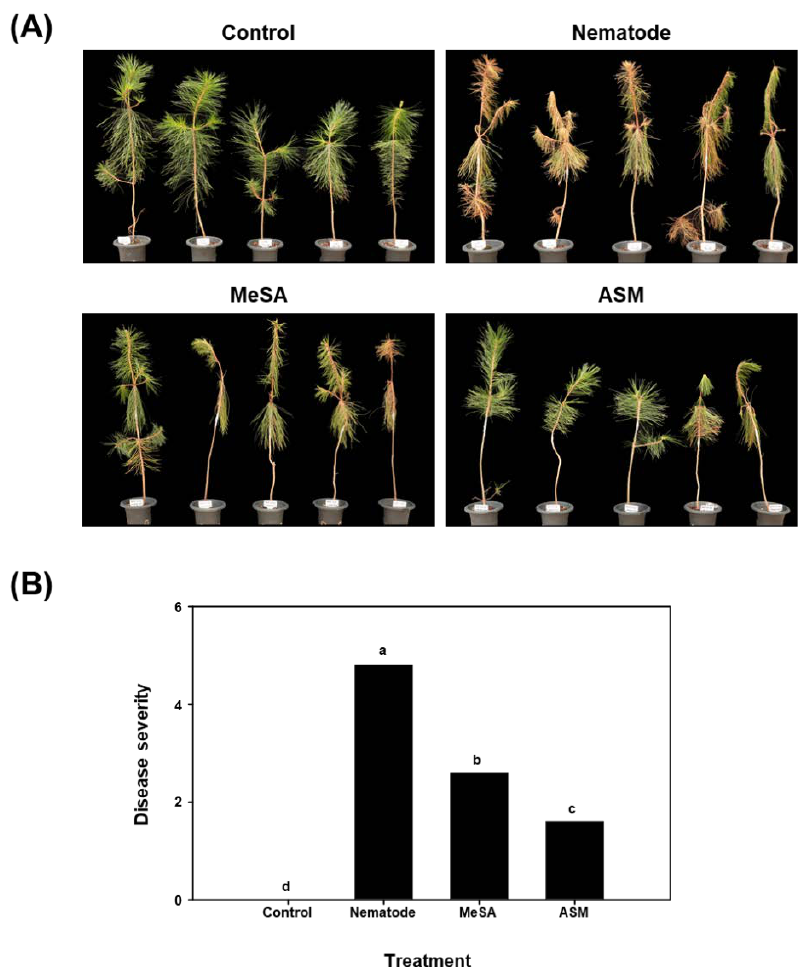
Figure 1. E ff ect of resistance-inducing chemical elicitors, methyl salicylic acid (MeSA), and acibenzolar-s-methyl (ASM), on the seedlings with pine wilt disease (PWD). ( A ) Photographs showing the PWD symptoms developed by pine ( Pinus densiflora ) seedlings treated with resistance-inducing chemical elicitors. Untreated seedlings served as the negative control whereas, nematode inoculated seedlings served as the positive control. ( B ) Bar graphs represent the mean PWD severity from five seedlings per treatment; di ff erent lowercase letters on the bars indicate a significant di ff erence according to the least significant di ff erence test at p < 0.05. Evaluation of disease severity was conducted 30 days post-inoculation with the pine wood nematode Bursaphelenchus xylophilus .